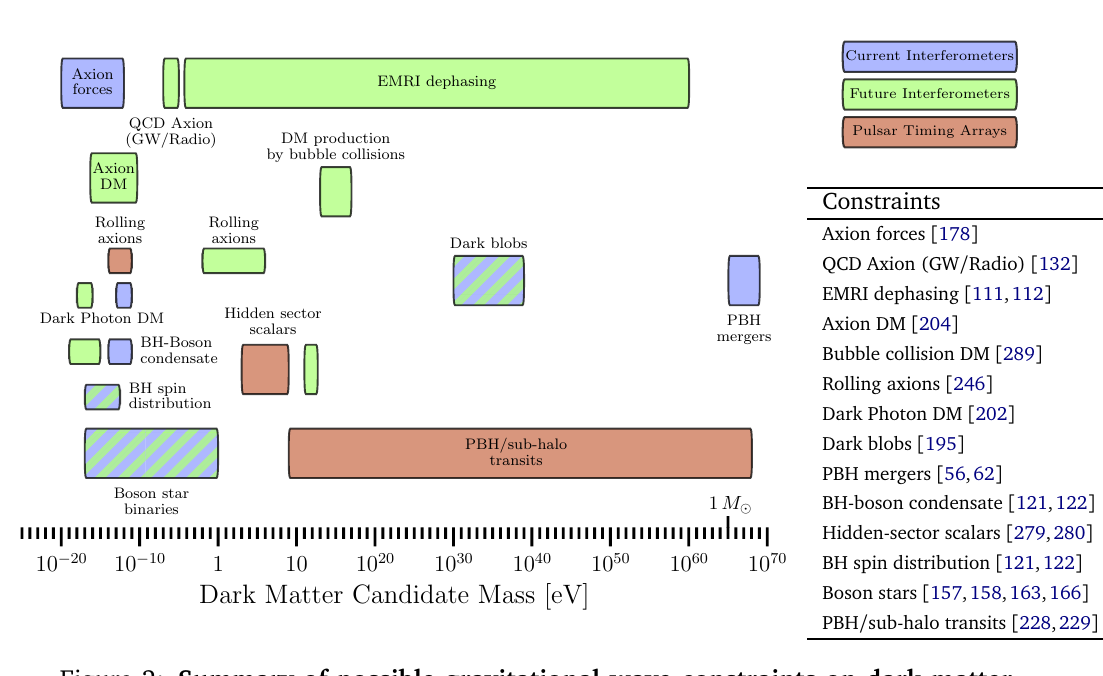
Figure 2: Summary of possible gravitational wave constraints on dark matter. We show the ranges of DM mass which are covered by potential constraints from grav- itational waves, using current interferometers (blue), future interferometers (green) and Pulsar Timing Arrays (red). Some representative references for each constraint are shown in the table on the right. See the main text for further details and refer-